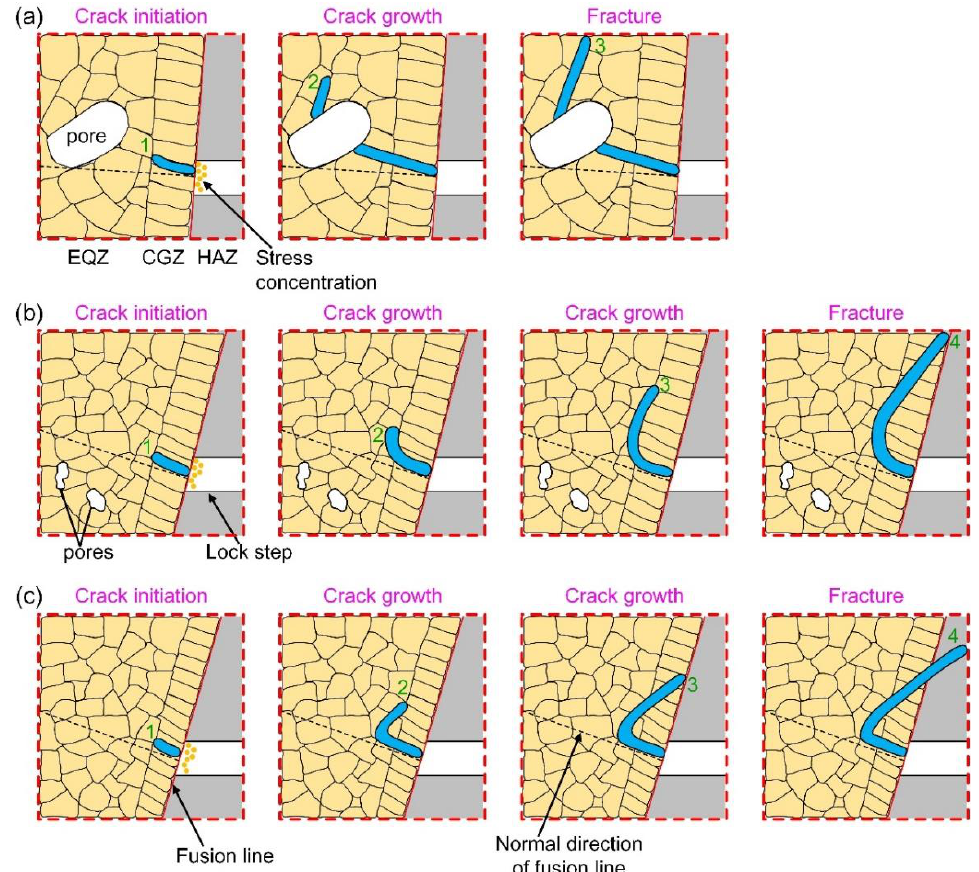
Figure 10. Fracture mechanism diagram, ( a ) fracture in EQZ, ( b ) fracture in CGZ, ( c ) fracture in